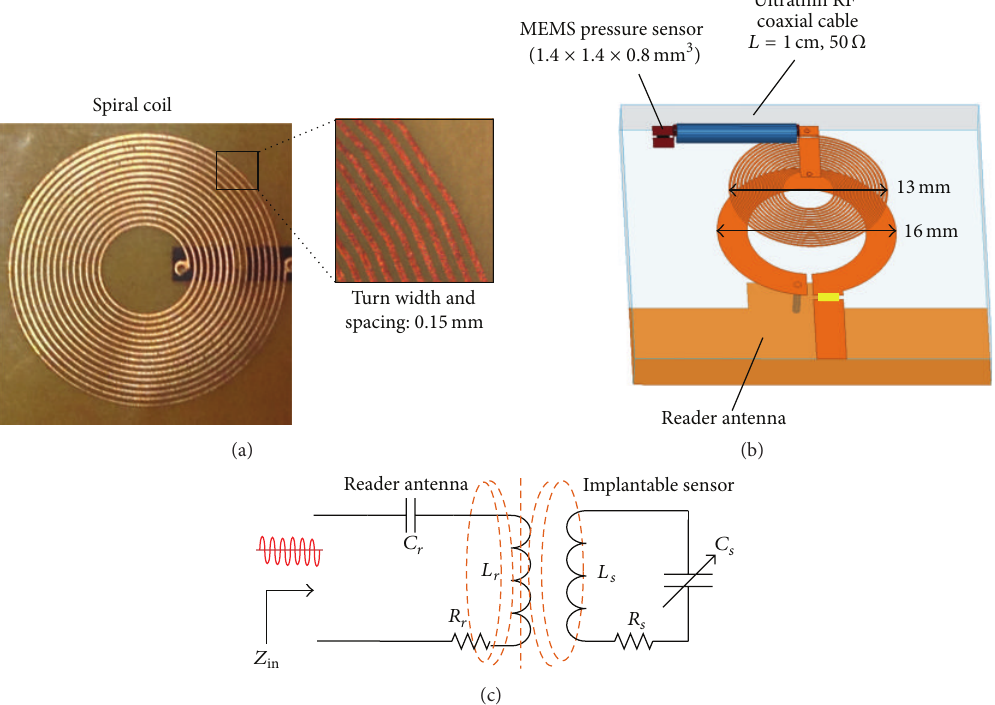
Figure 2: (a) Spiral coil of sensor B. (b) Simulated implant and reader antenna. (c) Telemetry model for wireless ICP monitoring.